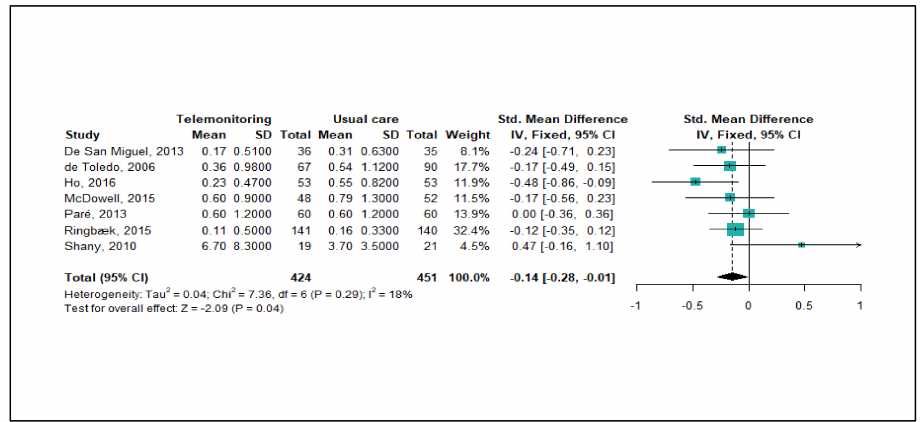
Figure 3. Forest plot for the effectiveness of telemonitoring for decreasing the number of ER visits due to severe COPD